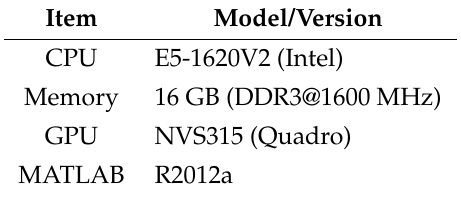
Table 4. The testing environment.